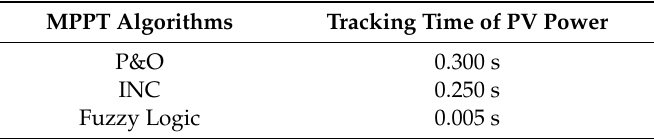
Table 5. Tracking time performance comparison [44]. P&O, perturb and observe; INC, incremental conductance.